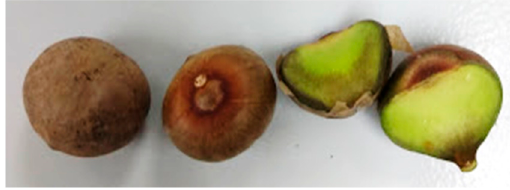
Figure 1. Ramon tree seeds, also called Maya nut. Table 2. Physical characteristics of fresh Maya nut.